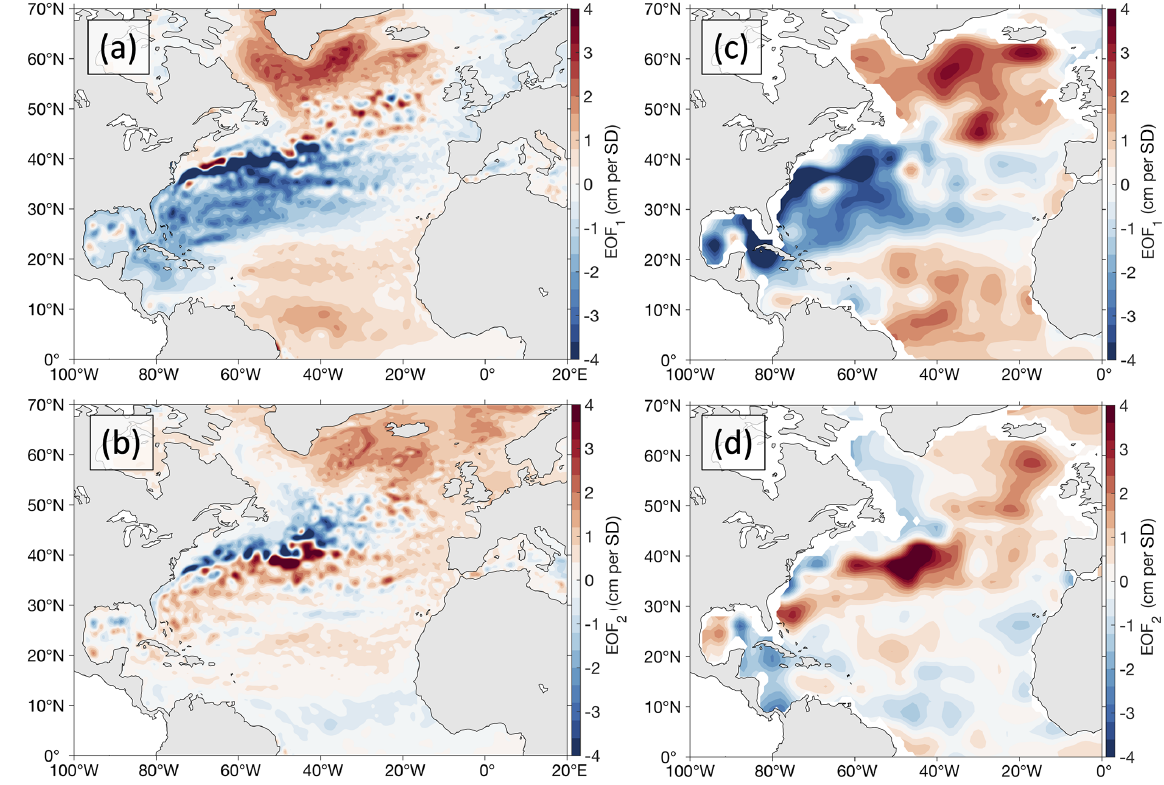
Figure 2. EOF analysis of sea level data: (a) EOF 1 and (b) EOF 2 modes of SSH anomalies measured by satellite altimetry; (c) EOF 1 and (d) EOF 2 modes of steric SSH anomalies derived from EN4 temperature and salinity